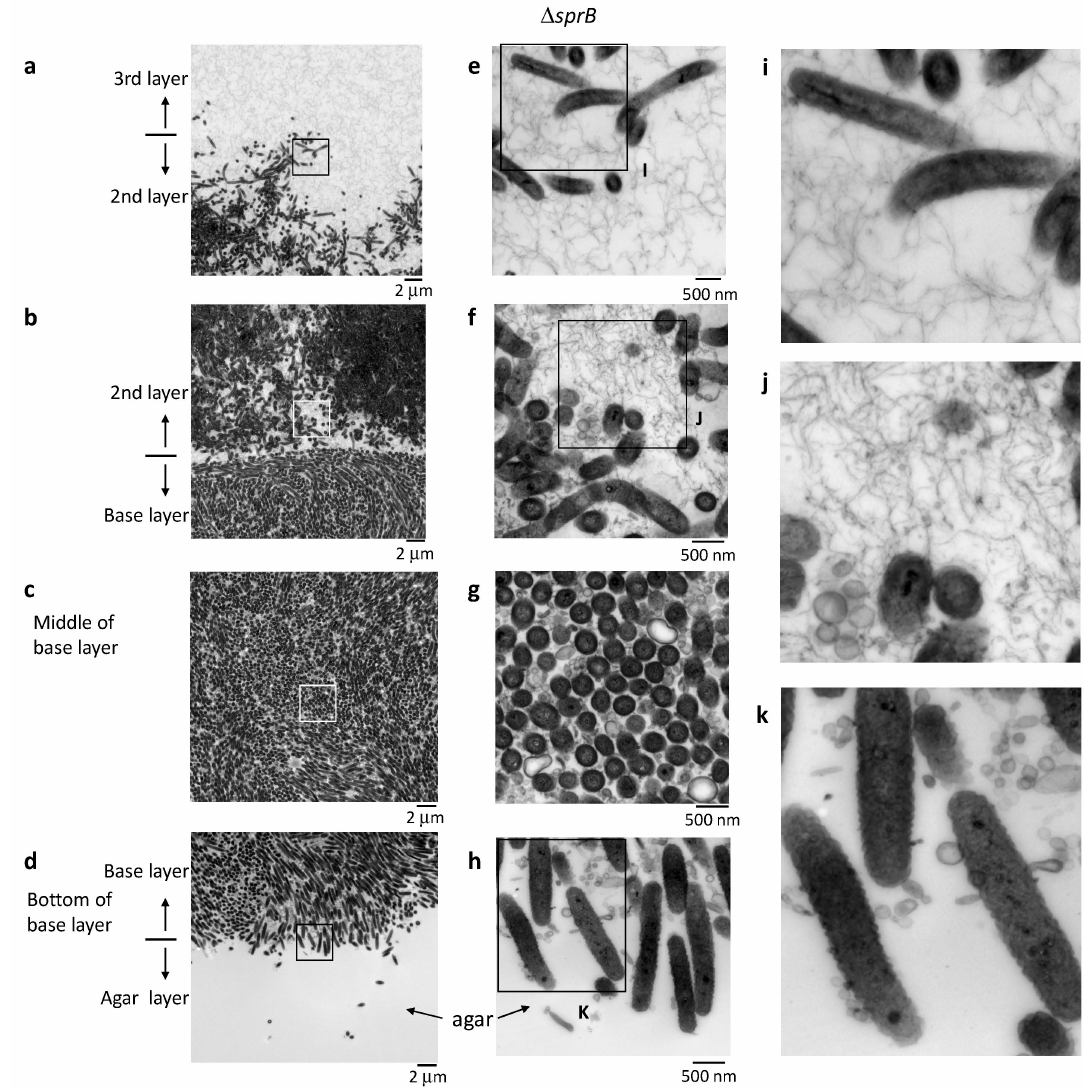
Figure 6. Colony spreading of the Δ sprB on 1% A-PY2. Higher-magnification images of cells shown in Figure 5. The corresponding position of each panel is indicated by the squares in Figure 5. ( a–d ) Left panels: Images of the spreading colony showing the bottom of the 3rd layer/top of the 2nd layer, the bottom of the 2nd layer/top of the base layer, middle of the base layer, and the bottom of the base layer/top of the agar, as indicated. ( e–h ) Middle panels: Higher magnification images of the regions shown on the left. ( i-k ) Right panels: Enlargement of the annotated regions shown on the left. The smaller intercellular space containing fewer filaments and vesicles suggests that the biofilm formed by the Δ sprB is immature.